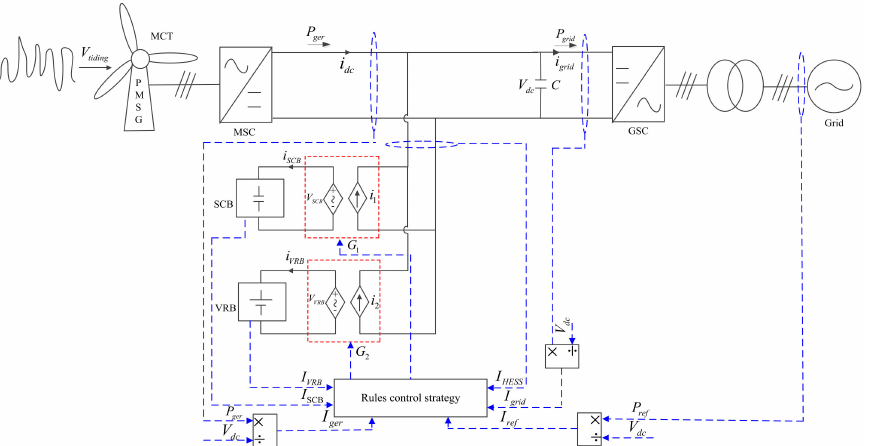
Figure 10. Control structure based on rule-based control strategy.